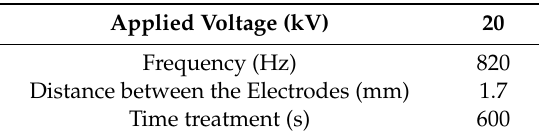
Table 1. Parameters used for the